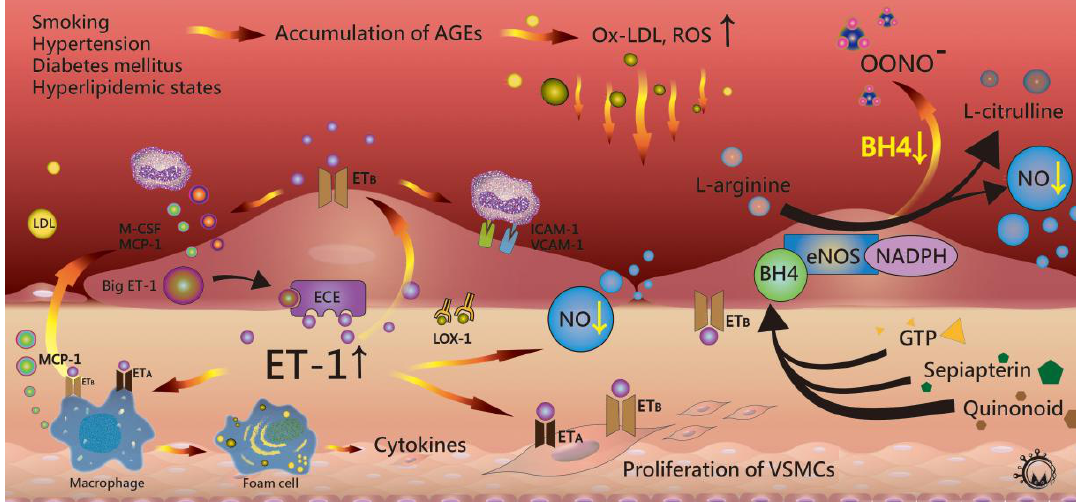
Figure 2. Hyperlipidemic status and other conditions can induce the accumulation of advanced glycation end products (AGEs), leading to increase reactive oxygen species (ROS) and retention of oxidized low-density lipoprotein (ox-LDL). Oxidative stress causes endothelial dysfunction and impairs the release of nitric oxide (NO) and endothelin-1 (ET-1). In atherosclerotic lesions, elevated tissue levels of ET-1 bind to ET B receptors on endothelial cells and cause expression of endothelial cell adhesion molecules, such as intercellular adhesion molecule-1 (ICAM-1) and vascular-cell-adhesion molecule-1 (VCAM-1). ET-1 promotes monocyte migration and activation by monocyte chemoattractant protein-1 (MCP-1), which is released from activated macrophages and endothelial cells. ET-1 also activates vascular smooth muscle cells (VSMCs) via ET A receptors to promote SMC proliferation. Oxidative stress also causes lower tissue levels of BH4 and induces the uncoupling of endothelial nitric oxide synthase (eNOS) and superoxide.